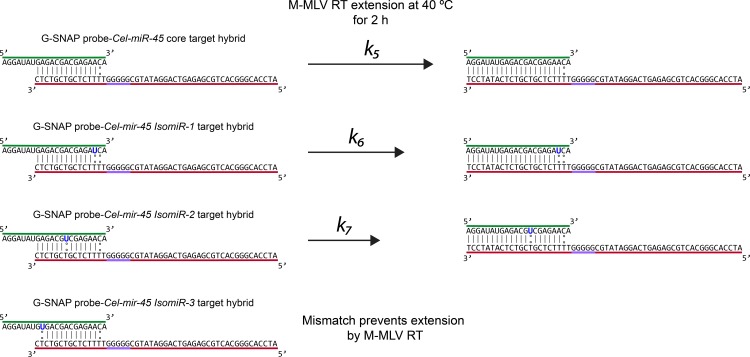
Working principle of how M-MLV RT extends G-SNAP probes hybridised with Cel-miR-54, IsomiR-1, IsomiR-2, and IsomiR-3.IsomiR-3 however does not allow for extension due to the presence of the mismatch towards the 5' end of the miRNA (correspondingly at the 3’ end of the G-SNAP probe).